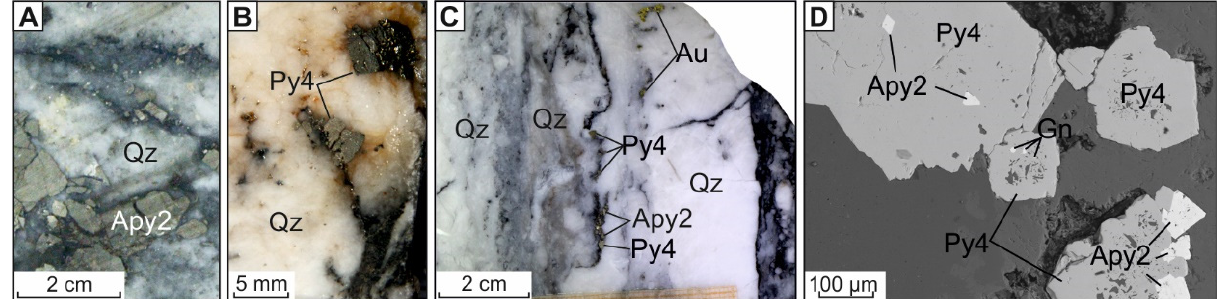
Figure 8. ( A – C ) Photographs and ( D ) photomicrograph of Py4 and Apy2 of Khangalas deposit (in backscattered electrons): ( A ) nest-like clusters and individual idiomorphic Apy2 crystals in quartz; ( B ) idiomorphic Py4 grains in quartz; ( C ) gold–polysulfide association with Py4, Apy2 in banded quartz; ( D ) Py4-Apy2 intergrowths with scattered galena (Gn) in quartz.